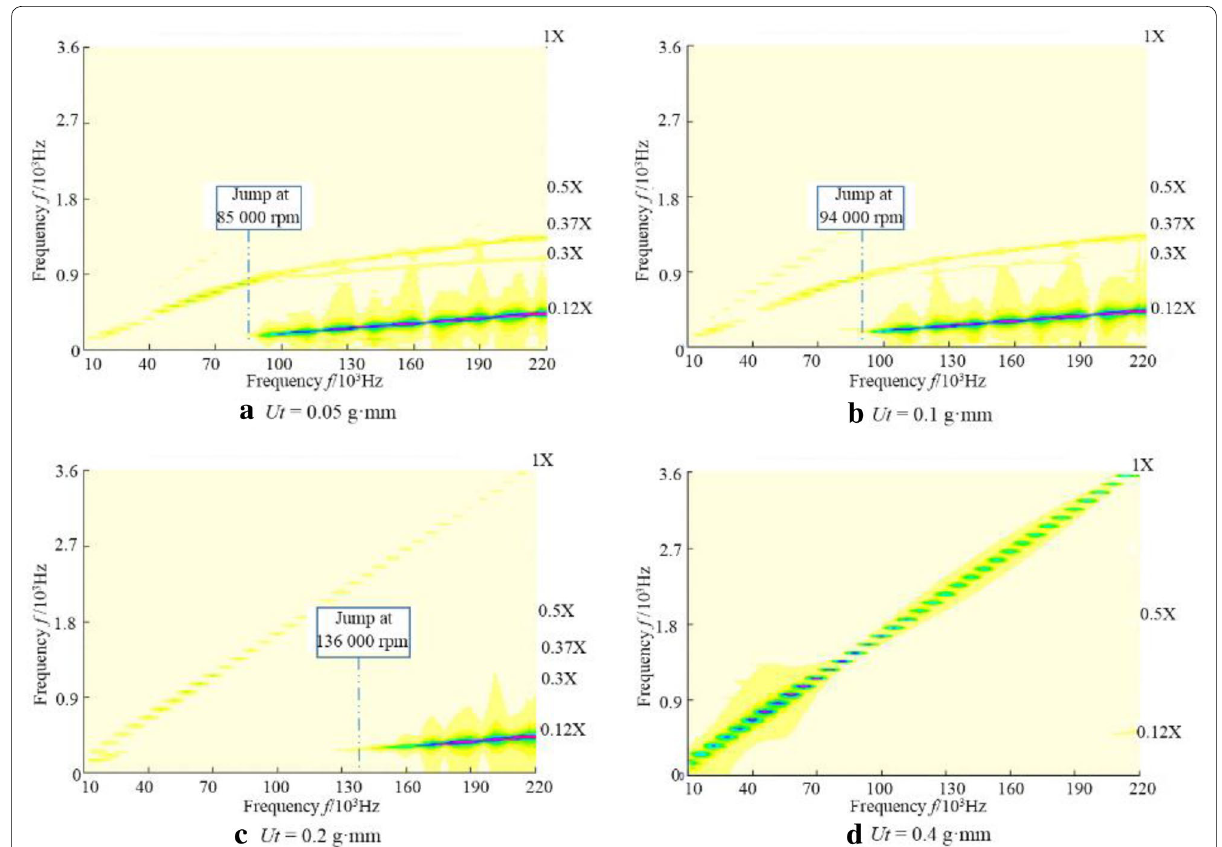
Figure 7 Response spectral intensity plots of stn 20 for four different unbalance amplitudes in TW nose of